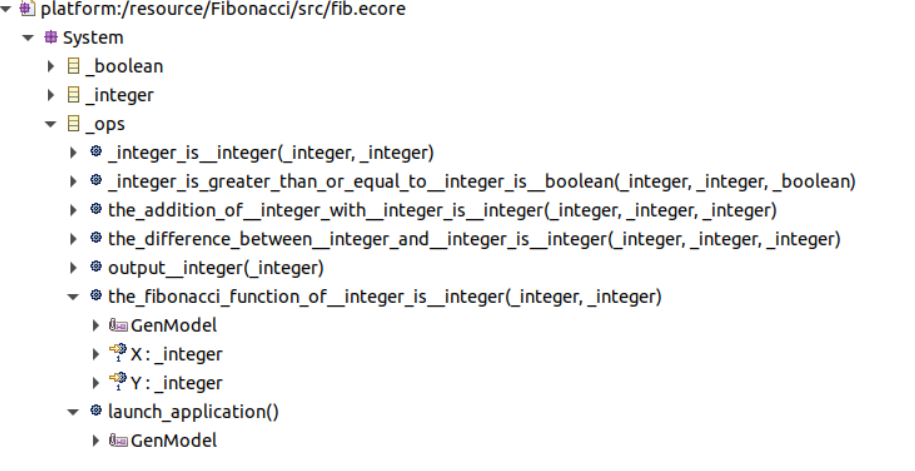
Figure 5. Ecore model compiled from the REX text in the “Fibonacci” example. Listing 18. Java code entered manually for the “Fibonacci” example